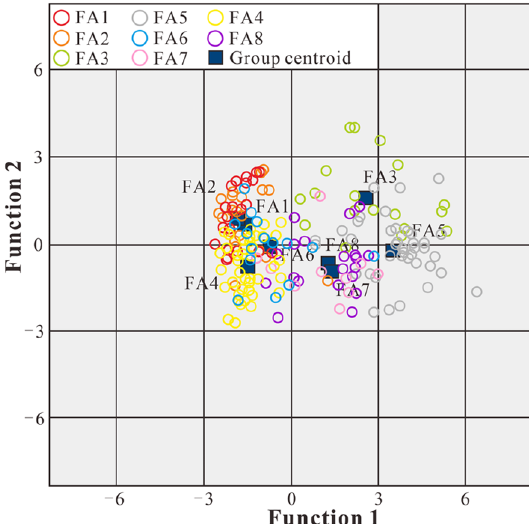
Figure 15. Typical discriminant function domain